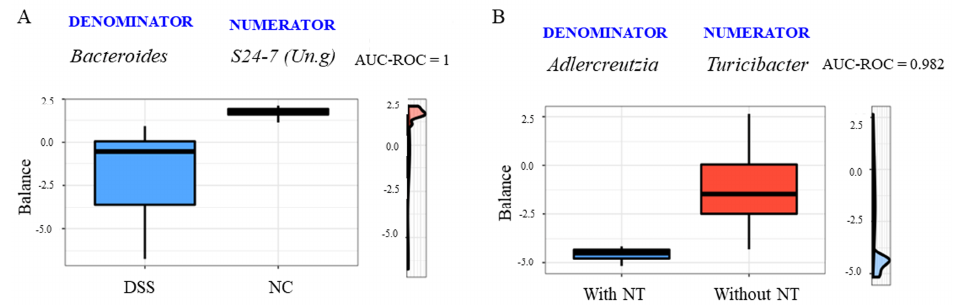
Figure 5. Microbial signatures or global balances selected by the selbal algorithm with a strong accuracy to distinguish colitis phenotypes ( A ) or neoagarotetraose (NT) supplementation status ( B ). AUC = Area under the ROC (Receiver Operating Characteristics) curve. The box plots represent the distribution of the balance values for each category. The right (vertical) panel of the figure represents density curves for each category. NC: normal controls; B: colitis induced by dextran sulfate